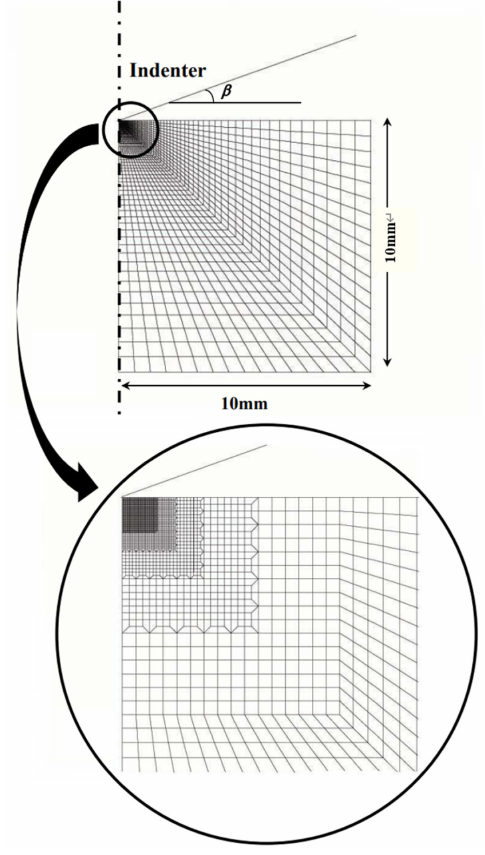
Figure 1. Detail of the FEM model geometry adopted in this study.